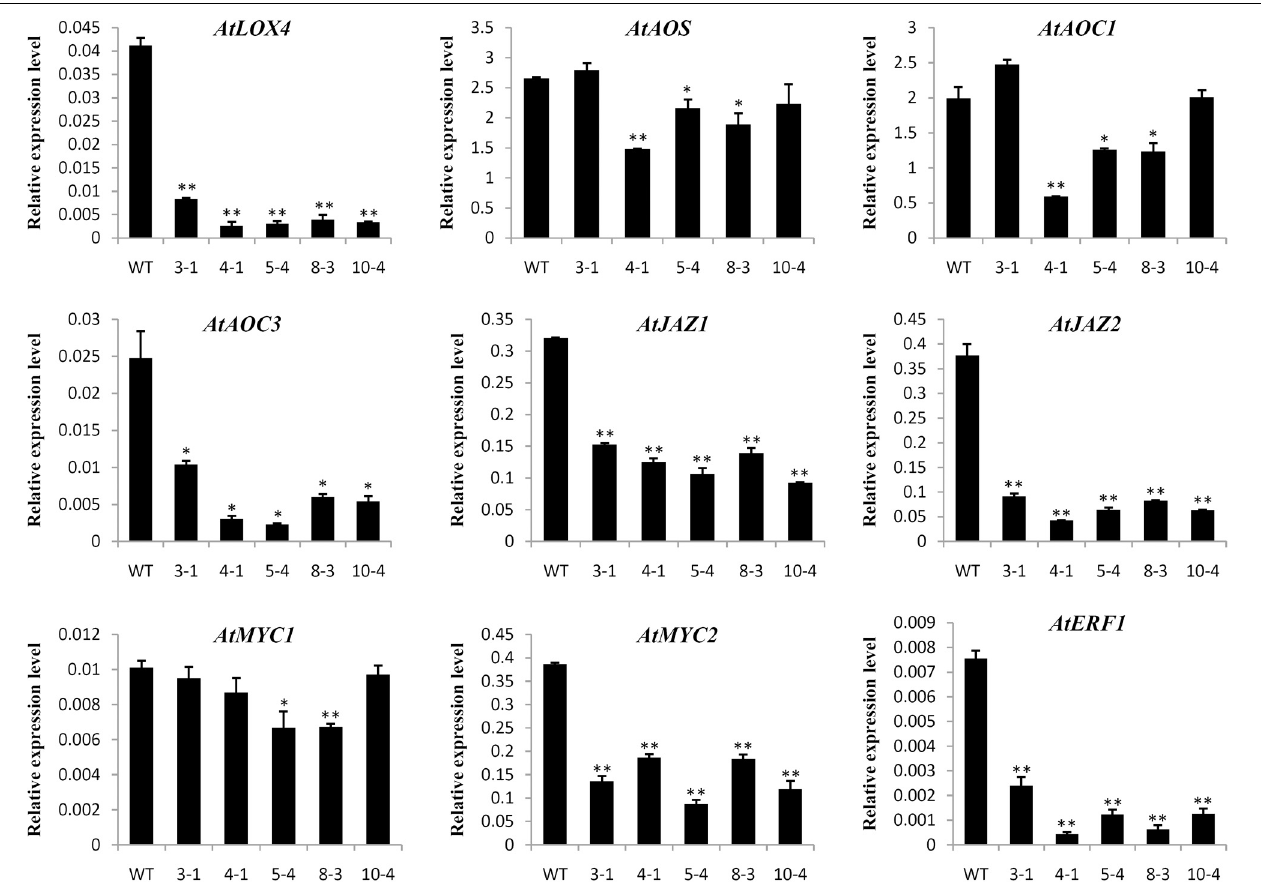
FIGURE 6 | Relative expression level of the genes related to JA biosynthesis and response in wild-type and GrTCP11 -overexpressed transgenic lines (3-1, 4-1, 5-4, 8-3, and 10-4). The accession numbers of the genes are as follows: AtLOX4, AT1G72520; AtAOS, AT5G42650; AtAOC1, AT3G25760; AtAOC3, AT3G25780; AtJAZ1, AT1G19180; AtJAZ2, AT1G74950; AtMYC1, AT4G00480; AtMYC2, AT1G32640; AtERF1, AT3G23240. Gene expression values are relative to reference AtACT2 expression; error bars represent the standard deviation of three biological replicates. Asterisks indicate a significant difference ( ∗ P < 0.05; ∗∗ P < 0.01) relative to the corresponding wild-type, using Student’s t